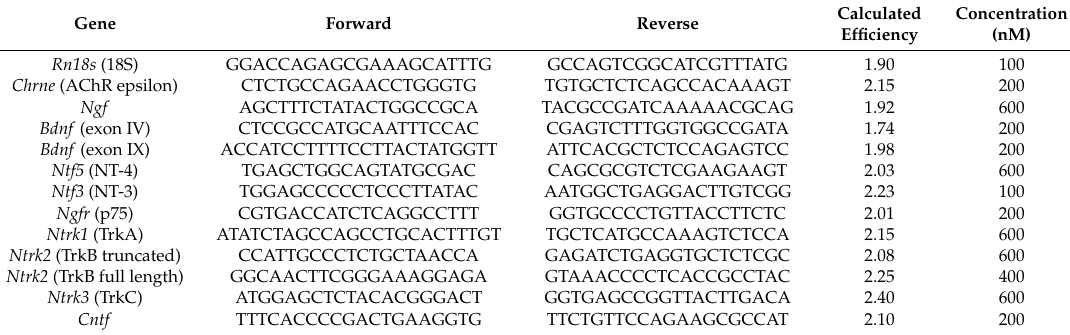
Table 3. Primer sequences and concentrations used for genes